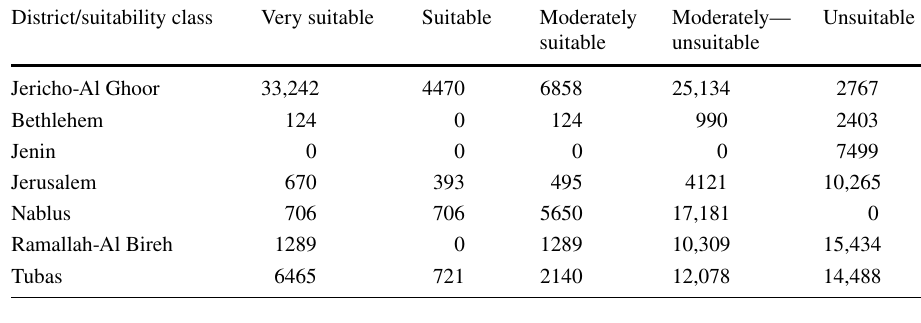
Fig. 6 Share of land